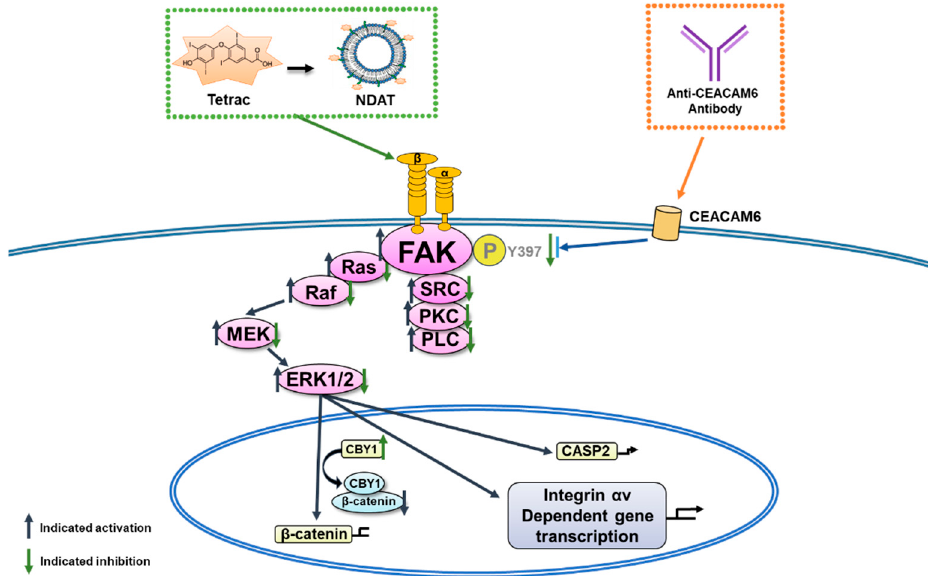
Figure 2. Signal transduction pathways in integrin α v β 3-FAK and crosstalk with CEACAM6. Signals via integrin α v β 3 or CEACAM6 phosphorylate and activate the FAK signal pathway to regulate cancer cell proliferation. Blocking the integrin α v β 3 pathway by thyroid hormone deaminated analogue, tetrac, and its nanoderivative (NDAT) can inhibit CEACAM6 pathway. On the other hand, anti-CEACAM6 antibody also blocks integrin α v β 3 downstream FAK pathway for cell proliferation.